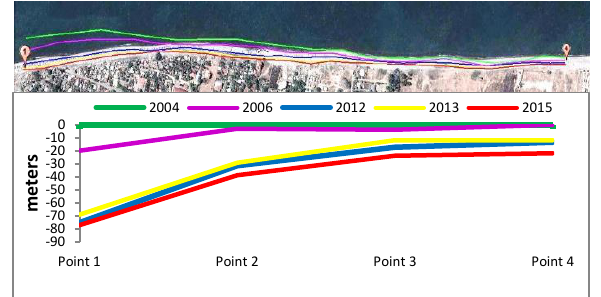
Figure 4. North Coast of the Bucao River